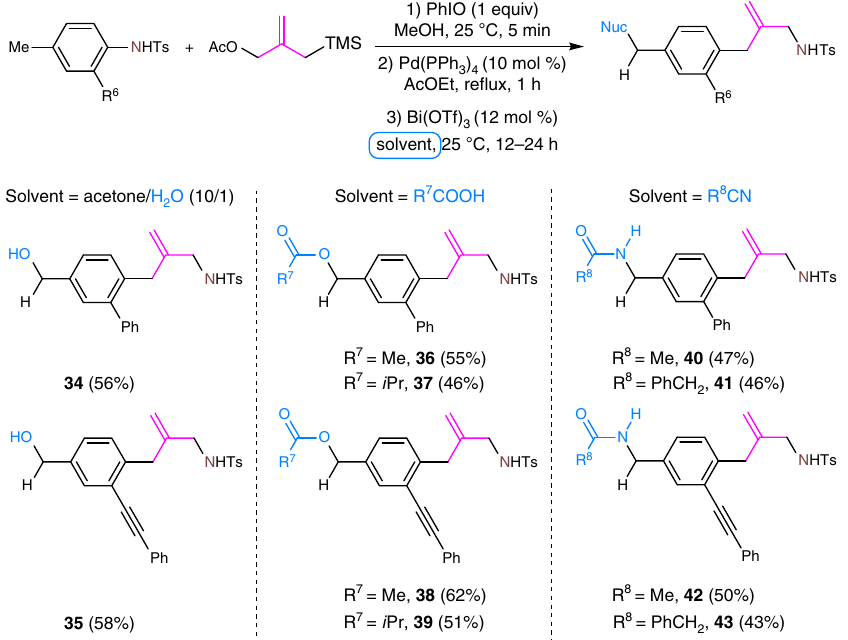
Fig. 5 Variable benzylic functionalization by varying rearrangement solvent. Nuc nucleophile. Nuc and the groups in corn fl ower blue means that it is a newly incorporated group. Solvent in a corn fl ower blue square frame means that it acts as a